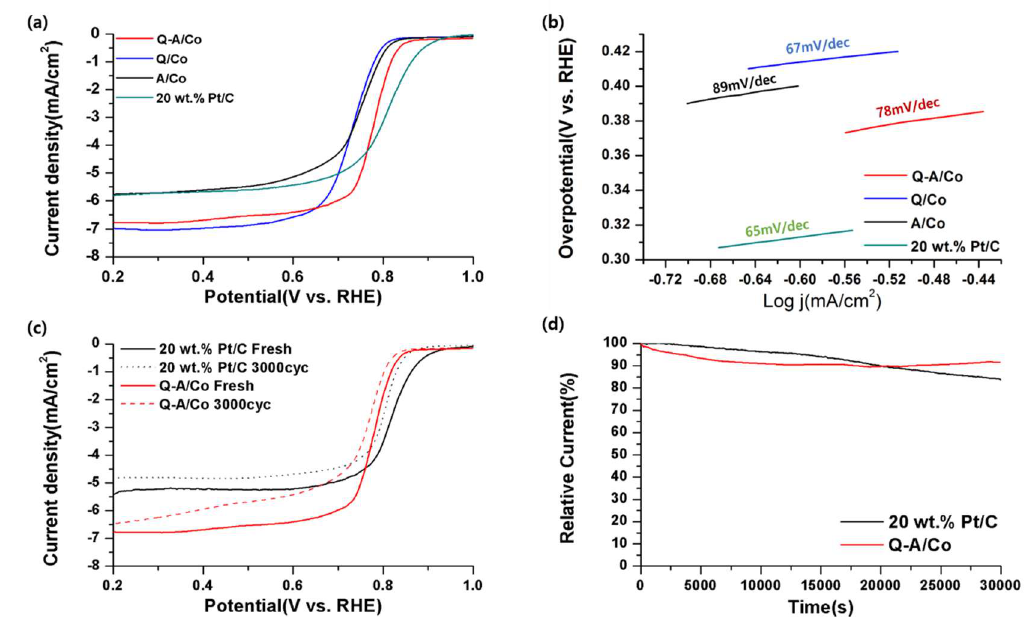
Figure 7. ( a ) Linear sweep voltammetry (LSV) curve of Co-N-doped carbon and 20 wt.% Pt/C at 5mV/s in O 2 saturated 0.1 M KOH in rotation speed 1600 rpm. ( b ) Correlated Tafel slope from each LSV curve. ( c ) Cycle durability of Q-A/Co and 20 wt.% Pt/C after 3000 cycles. ( d ) Chronoamperometry (CA) of Q-A/Co and 20 wt.% Pt/C at 0.6 V vs. RHE. Table 3. Summary of the electrochemical catalytic activity of Co-N-doped carbon and 20 wt.% Pt/C.